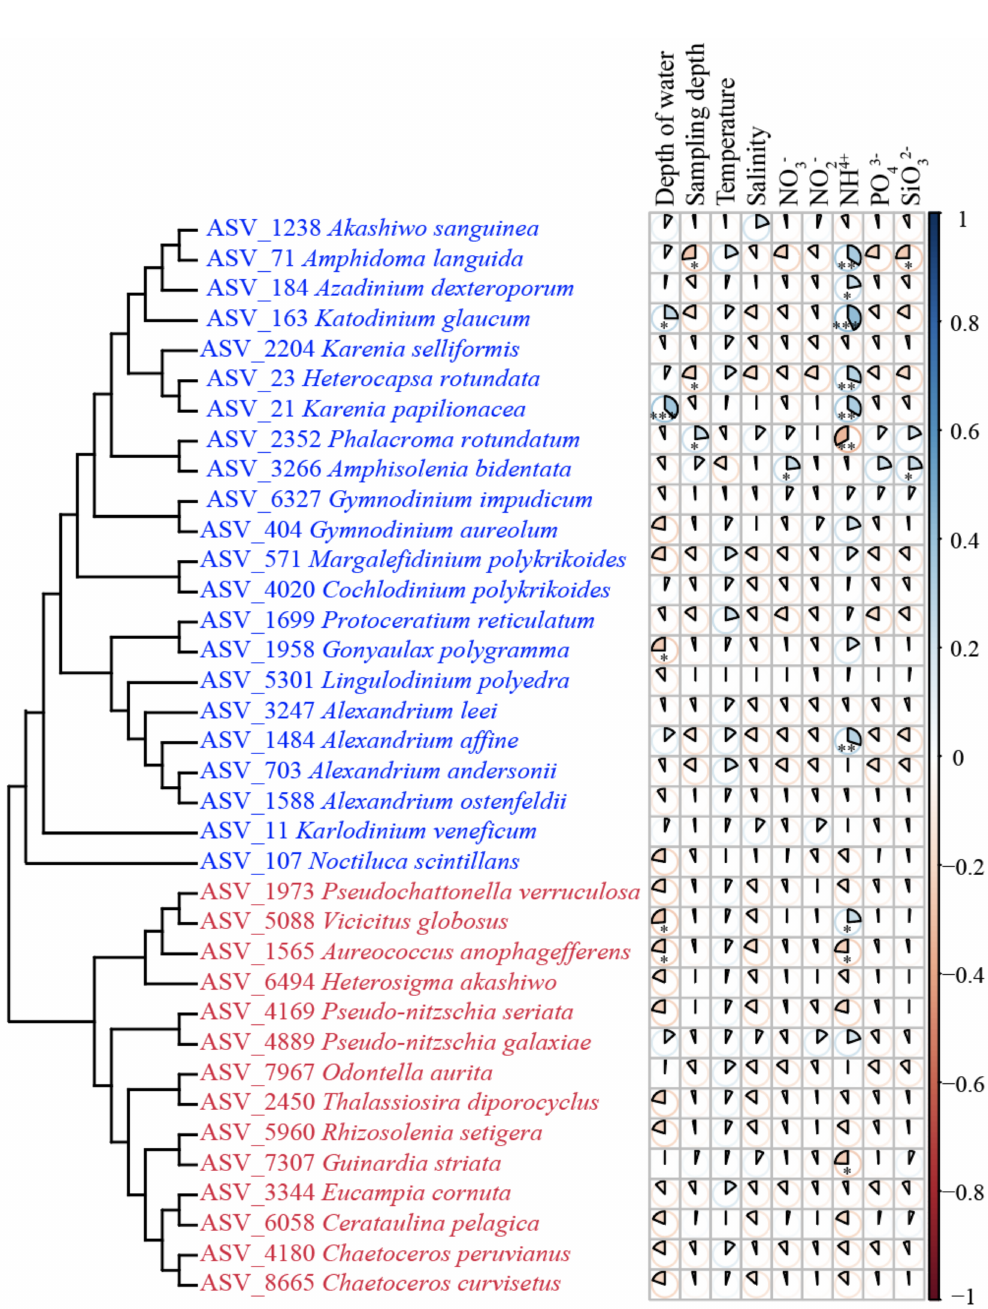
Figure 10. Pairwise comparisons of environmental factors and 36 HAB species. The pies with * indicate that p -value < 0.05; the pies with ** indicate p -value < 0.01; the pies with *** indicate p -value <